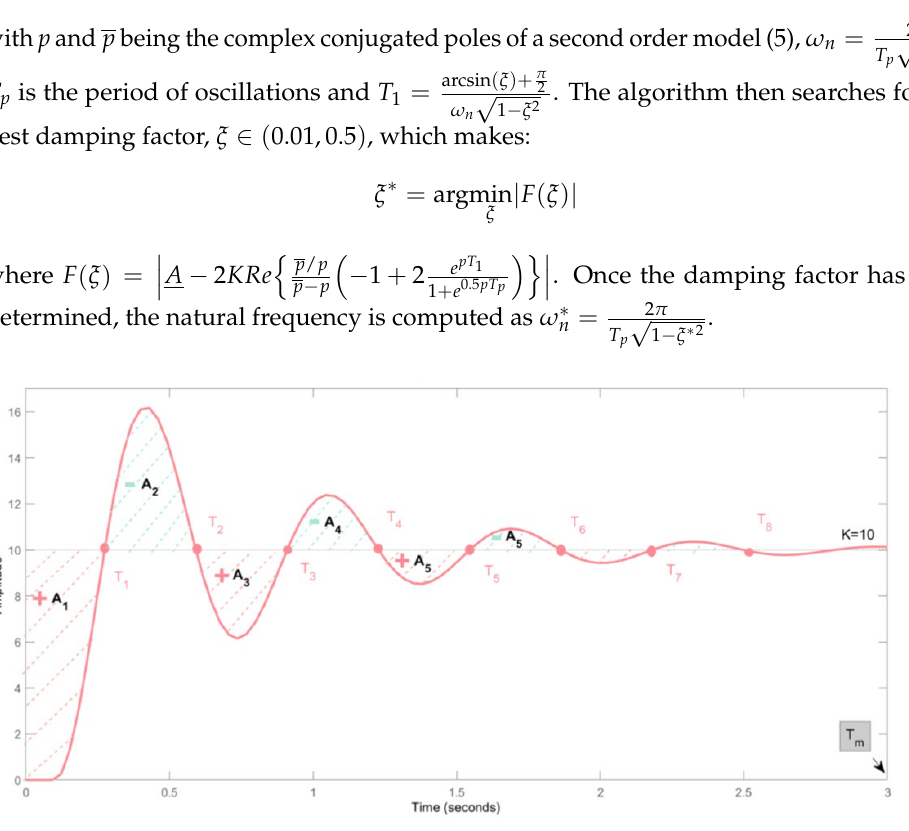
Figure 2. Corresponding areas for the algorithm on an underdamped system response.